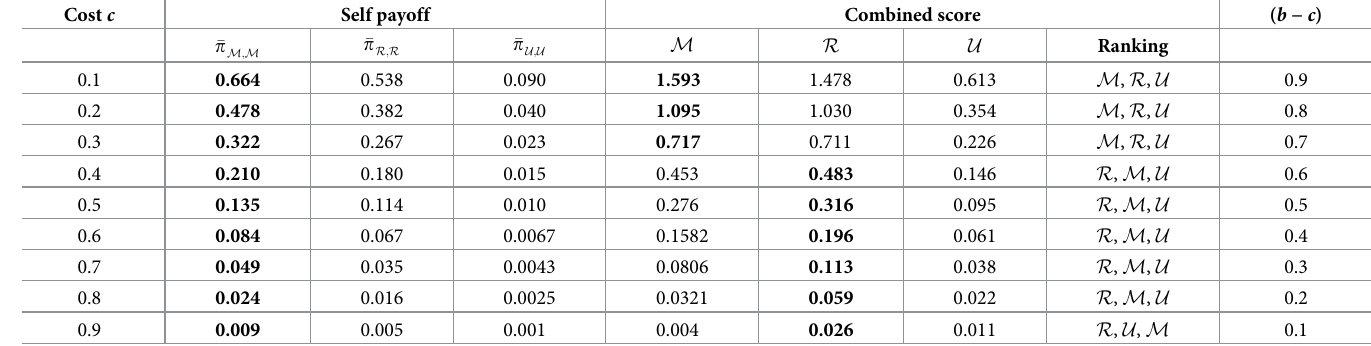
Table 3. Self scores and combined scores in pairwise tournaments. In addition to the wins and the scores considered in Table 2, we consider two additional measures for a memory space’s success. A memory space’s self payoff is the payoff two players with the respective memory space obtain against each other. The combined score is the sum of the memory space’s score and its self payoff. Again, winners are marked in bold face. Across all cooperation costs, we find that memory-1 strategies yield the largest self payoff. They also achieve the largest combined score if c � 0.3; otherwise, for c � 0.4, reactive strategies succeed. Parameters are the same as in Table 1. Cost c Self payoff